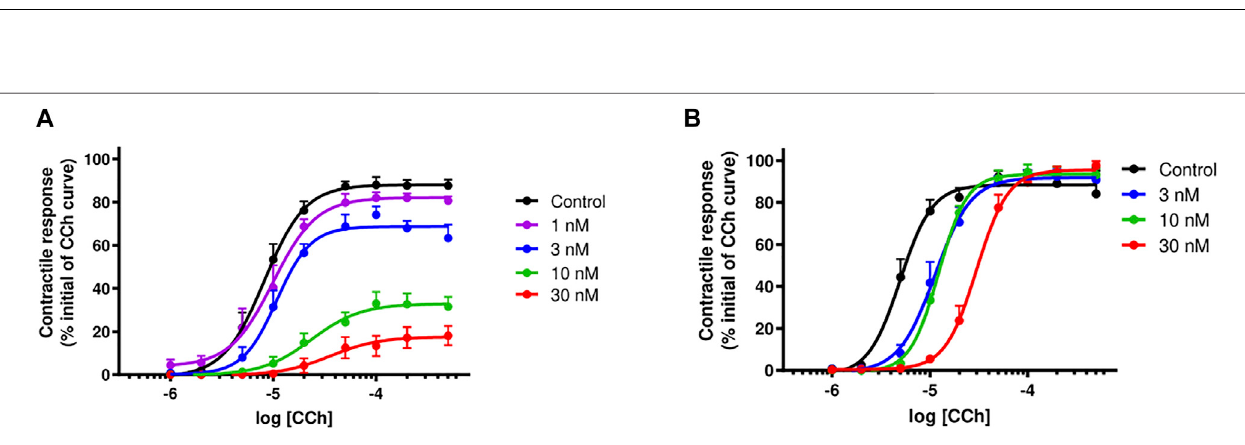
Frontiers in Pharmacology |